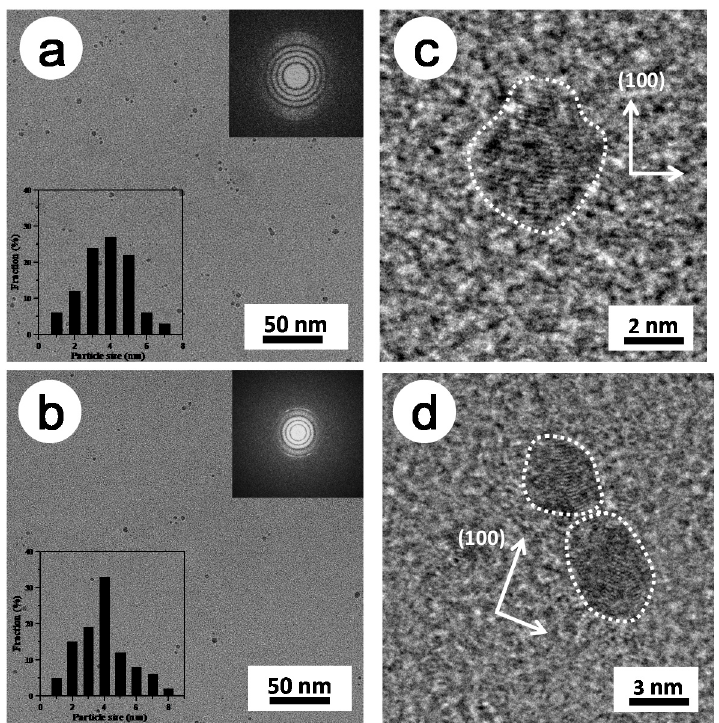
Figure 1. TEM micrographs of ( a ) N-doped graphene quantum dots (GQD) and ( b ) B-N-codoped GQD samples. The corresponding histograms have also been shown within the insets. The lattice fringes of ( c ) N-doped GQD and ( d ) B-N-codoped GQD samples.